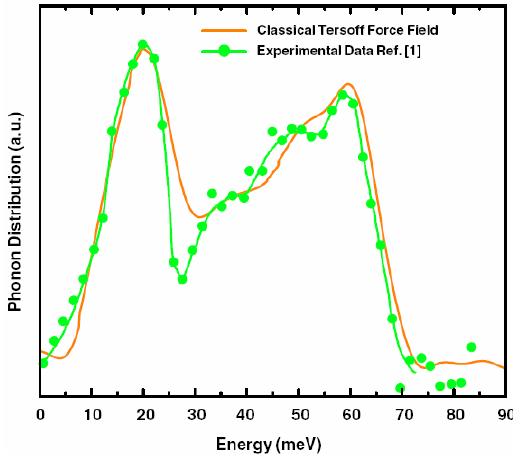
Figure 41. Classical vDOS, based on the Tersoff potential [119], for our 216-atom a -Si network (orange curve), compared to the experimental results of Kamitakahara et al. (green curve and dots) [120,121].